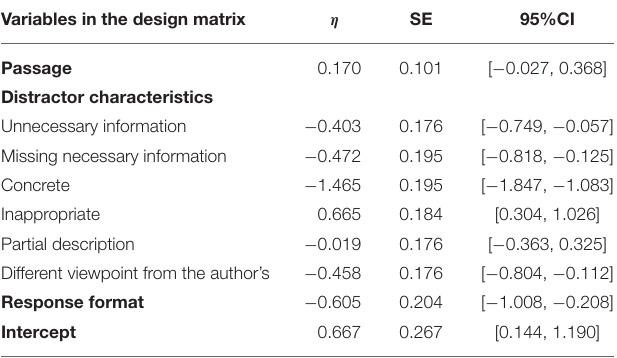
TABLE 6 | Parameter estimates and 95% confidence intervals in